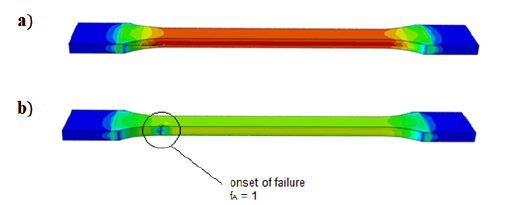
Figure 11. Illustration of location of stress concentra- tions; a) specimen before failure, b) failed specimen.